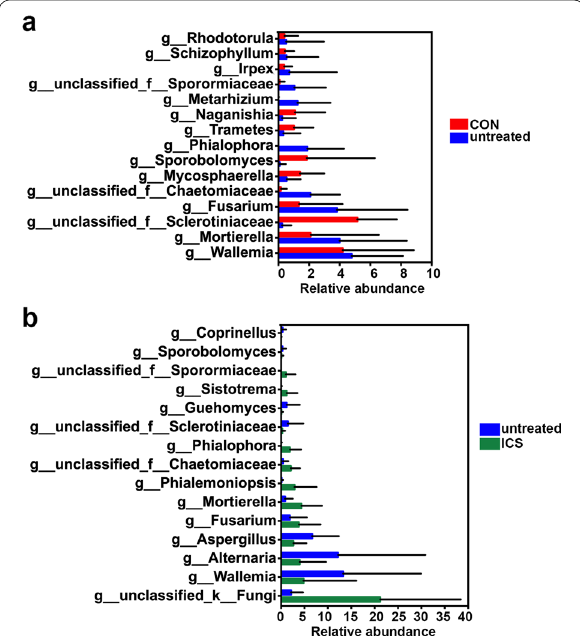
Fig. 2 Relative abundance of top 15 genera in airway mycobiome. Significantly differing mycobiome between CON and untreated asthma group ( a ), between untreated asthma group and ICS asthma group ( b ) were shown. Statistical significance was determined using Kruskal–Wallis rank-sum test. All p < 0.05